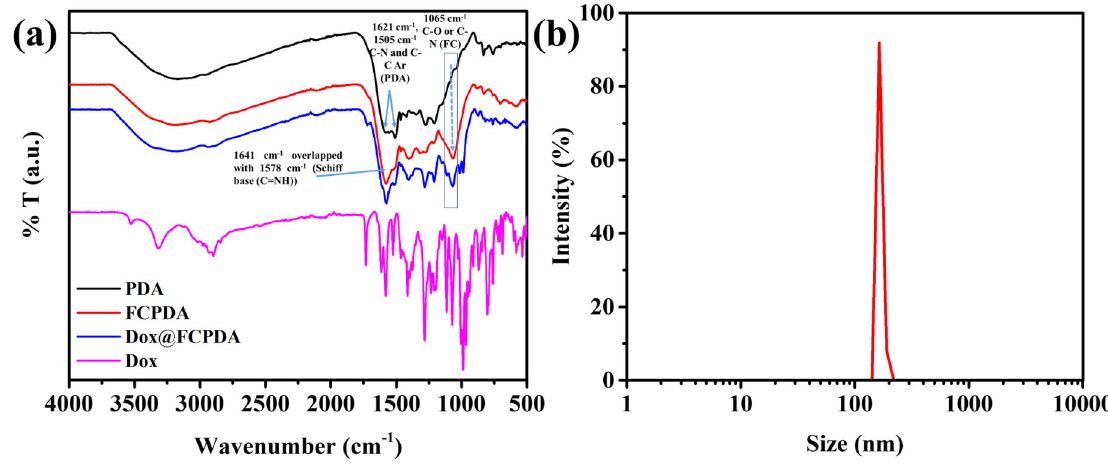
Figure 1. ( a ) FTIR spectra, ( b ) DLS average hydrodynamic size of FCPDA nanoparticles, and ( c ) TEM images of FCPDA nanoparticles. 3.2. UV-Vis-NIR Absorption Spectra Further, to explore the possible photo-thermal material, it was referred to as an opti- mal biological window due to its deeper tissue penetration depth and should exhibit a strong capacity for absorption in the NIR light range. As a result, the UV-Vis-NIR absorp- tion curves of FCPDA NPs aqueous solutions at varied concentrations were examined. Figure 2a shows that the absorbance at 808 nm (NIR window) of the FCPDA nanoparticles increased along with their concentration, which suggests that the FC functionalization with PDA did not in fl uence photothermal capacity. Therefore, it is conceivable that when concentration rose, the photo-thermal capacity would rise as well. Figure 2b is a graph that shows the linear correlation between wavelength at 808 nm and FCPDA concentra- tions, further demonstrating that concentration increased with the increase in absorbance value at a wavelength of 808 nm.